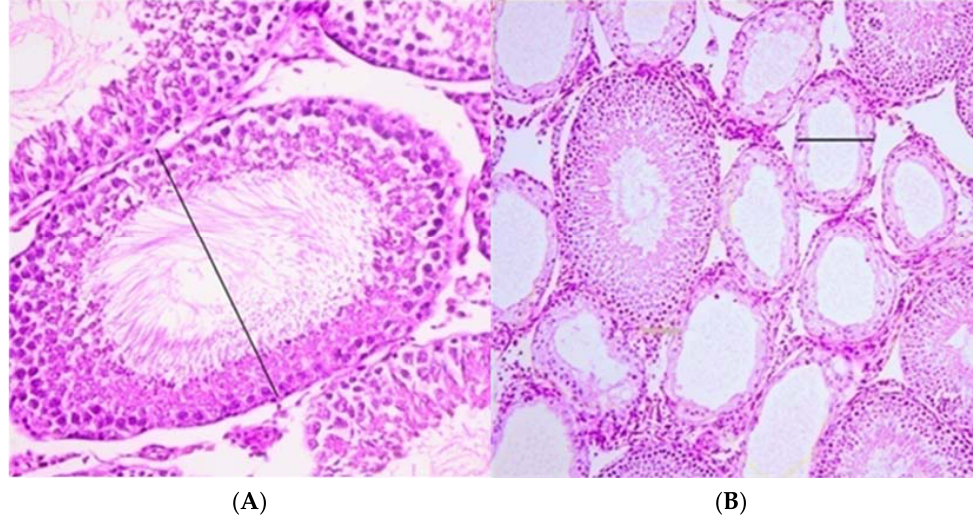
Figure 2. Histological measurement of tubules: ( A )—normal tubules, HE, magnification ×40; ( B )— atrophic tubules, HE, magnification ×20.